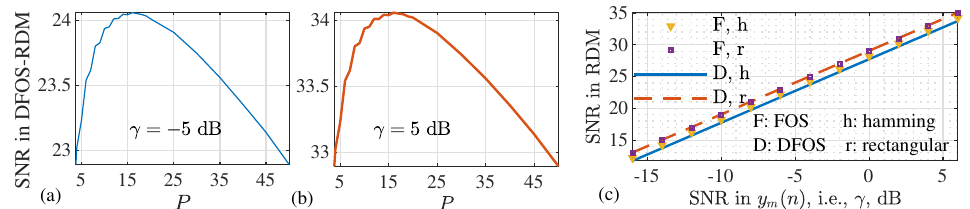
Figure 9. Illustration of SNR in DCOS-RDM versus P in ( a , b ); and ( c ) a comparative illustration of the SNR in RDM of both COS and DCOS versus γ , the SNR in (7). Parameter settings are summarized